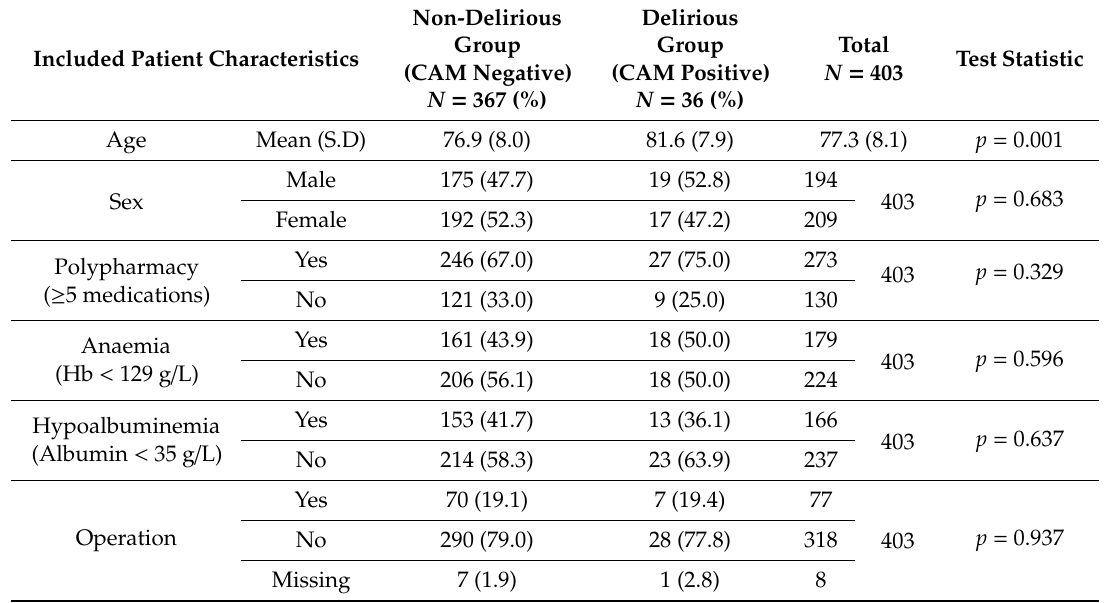
Table 2. Included patient characteristics of the delirious and non-delirious